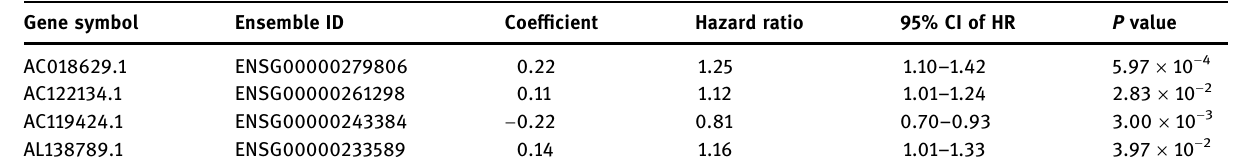
Table 2: Four lncRNAs signi fi cantly associated with the OS Gene symbol